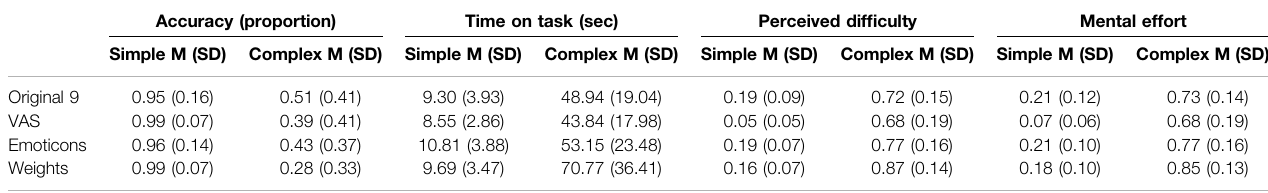
TABLE 3 | Proportion mean scores and standard deviations of the four rating scales for accuracy, time on task, and perceived dif fi culty and invested mental effort. Accuracy (proportion)